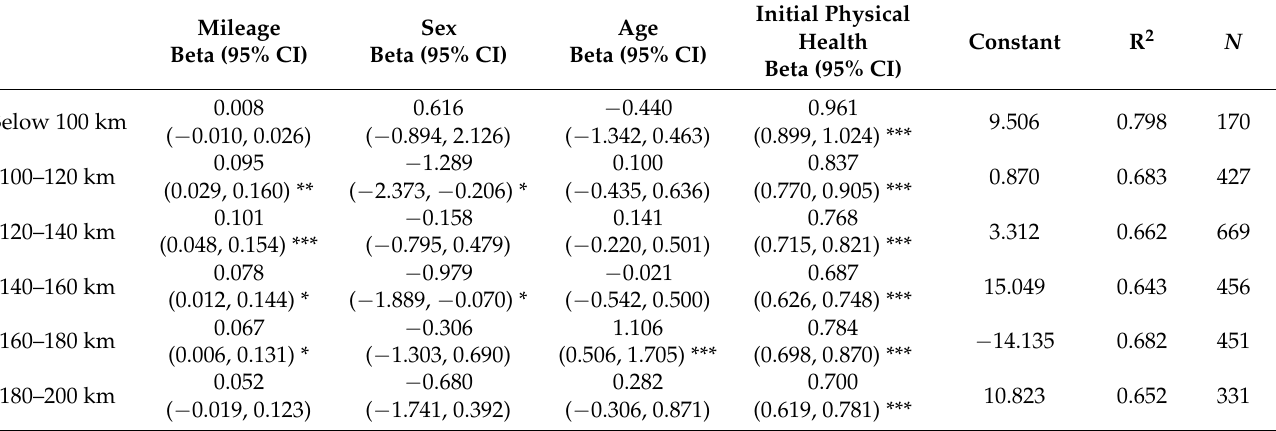
Table 2. Regression estimates of outdoor physical activity in green space on physical